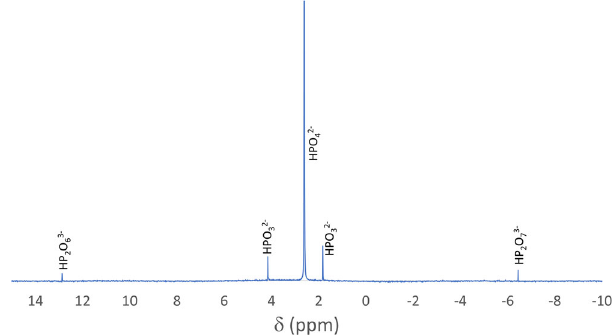
Fig. 2 31 P NMR of Fe – Si – CaHPO 4 (1:2:0.1 by mole) mixture heated to 1000°C for 8 h. The NMR spectrum, in which individual anions are referenced to a frequency of 161.907 MHz for H 3 PO 4 (0 ppm), identi fi es P species based on parts per million deviations ( δ ) from this frequency. The peaks correspond to (left to right) hypophosphate (P 4 + ), phosphite (P 3 + ), phosphate (P 5 + ), and pyrophosphate (P 5 + ). Note that phosphite is a broad